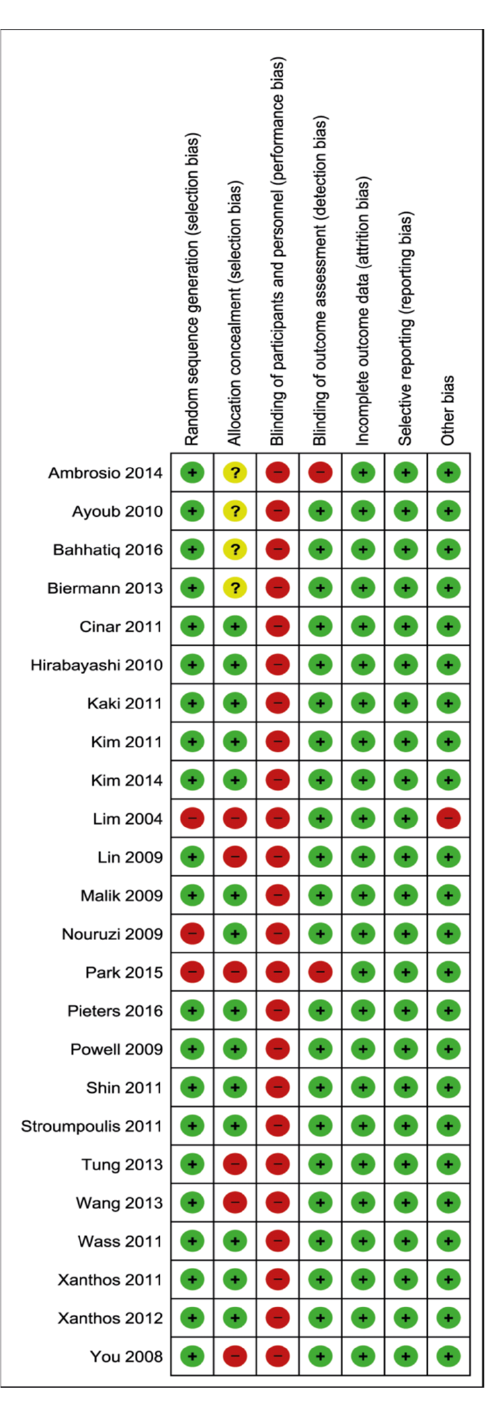
Figure 4. Risk of bias summary. Ambrosio, 2014 [32]; Ayoub, 2010 [36]; Bahhatiq, 2016 [34]; Biermann, 2013 [29]; Cinar, 2011 [21]; Hirabayashi, 2010 [37]; Kaki, 2011 [22]; Kim, 2011 [23]; Kim, 2014 [33]; Lim, 2004 [16]; Lin, 2009 [17]; Malik, 2009 [18]; Nouruzi, 2009 [38]; Park, 2015 [39]; Pieters, 2016 [35]; Powell, 2009 [19]; Shin, 2011 [25]; Stroumpoulis, 2011 [26]; Tung, 2013 [30]; Wang, 2013 [31]; Wass, 2011 [24]; Xanthos, 2011 [27]; Xanthos, 2012 [28]; You, 2009 [20]. Green +: low risk of bias, Red -: high risk of bias, Yellow ?: unclear risk of bias.